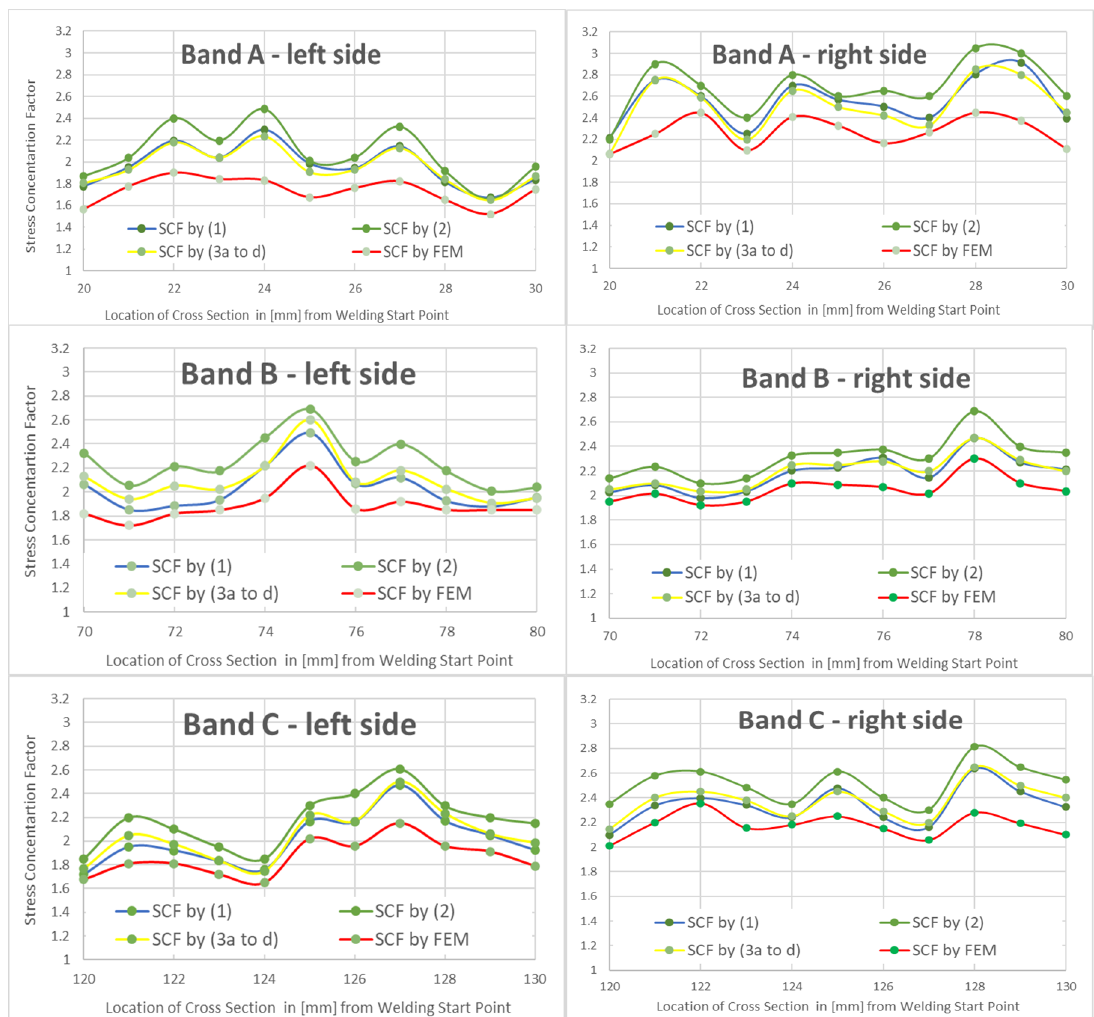
Figure 6. Comparison of SCFs.